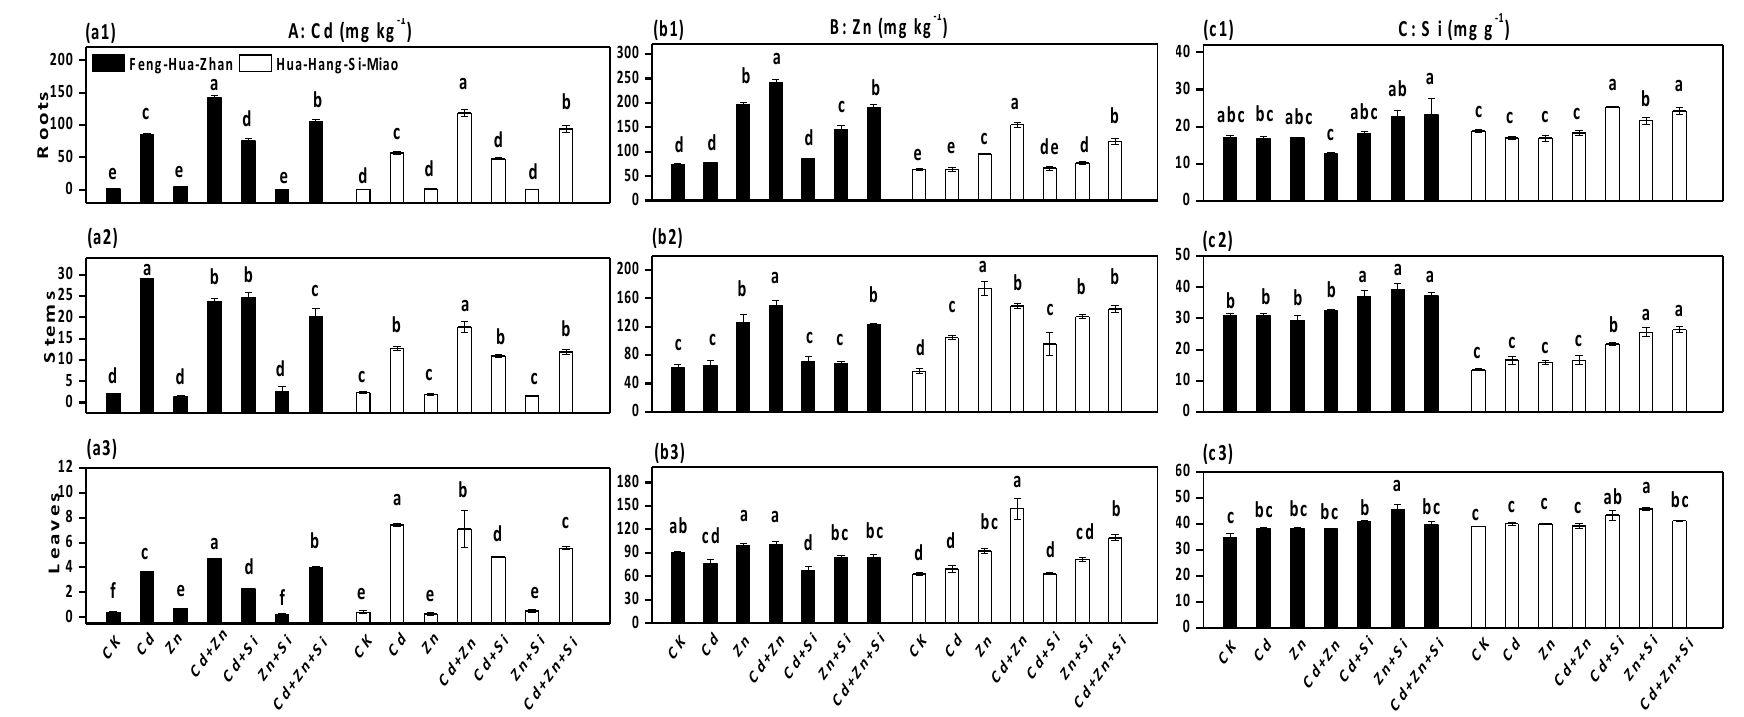
Figure+3. "Effect"of"Si"on"elements"content"in"different"rice"organs"at"the"tillering"stage:"( a1 ),"( b1 )"and"( c1 )"roots;"( a2 ),"( b2 )"and"( c2 )"stems;"( a3 ),"( b3 )"and"( c3 )"leaves."Error"bars"indicate" Figure 3. Effect of Si on elements content in different rice organs at the tillering stage: ( a1 ), ( b1 ) and ( c1 ) roots; ( a2 ), ( b2 ) and ( c2 ) stems; ( a3 ), ( b3 ) and ( c3 ) leaves. Error standard"deviations"( n "="4)."Bars"with"different"letters"are"significantly"different"( p% <"0.05)"according"to"Duncan’s"MRT." bars indicate standard deviations ( n = 4). Bars with different letters are significantly different ( p < 0.05) according to Duncan’s